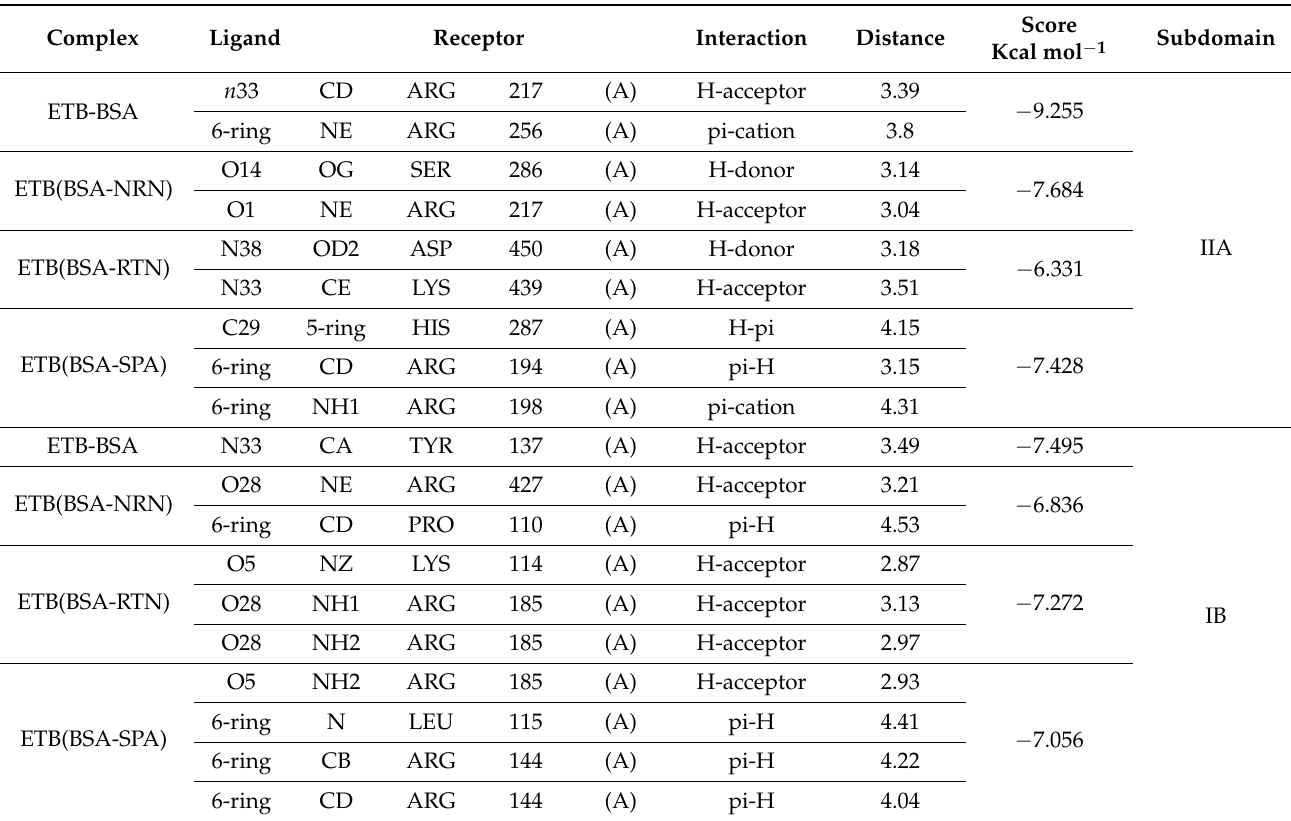
Figure 6. Two ‐ dimensional molecular ‐ docking conformation for BSA ETB system ( A ): Site I and ( B ): Figure 6. Two-dimensional molecular-docking conformation for BSA ETB system ( A ): Site I and ( B ): Site III. Site III. Table 4. Molecular-docking results for the binary and ternary BSA-ETB